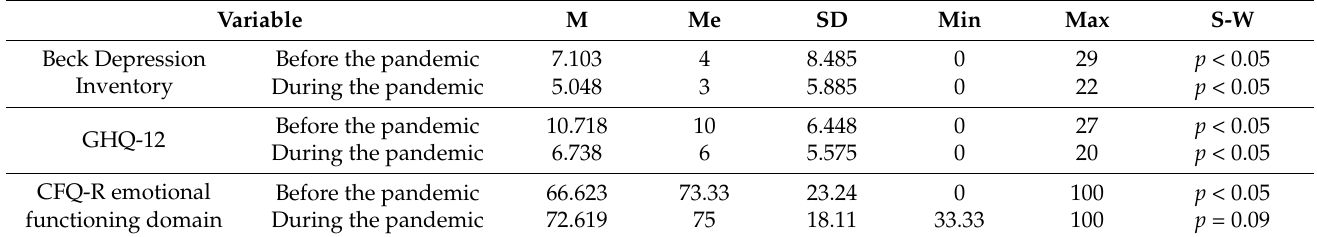
Table 2. Descriptive statistics of the scores obtained by patients and Shapiro–Wilk test